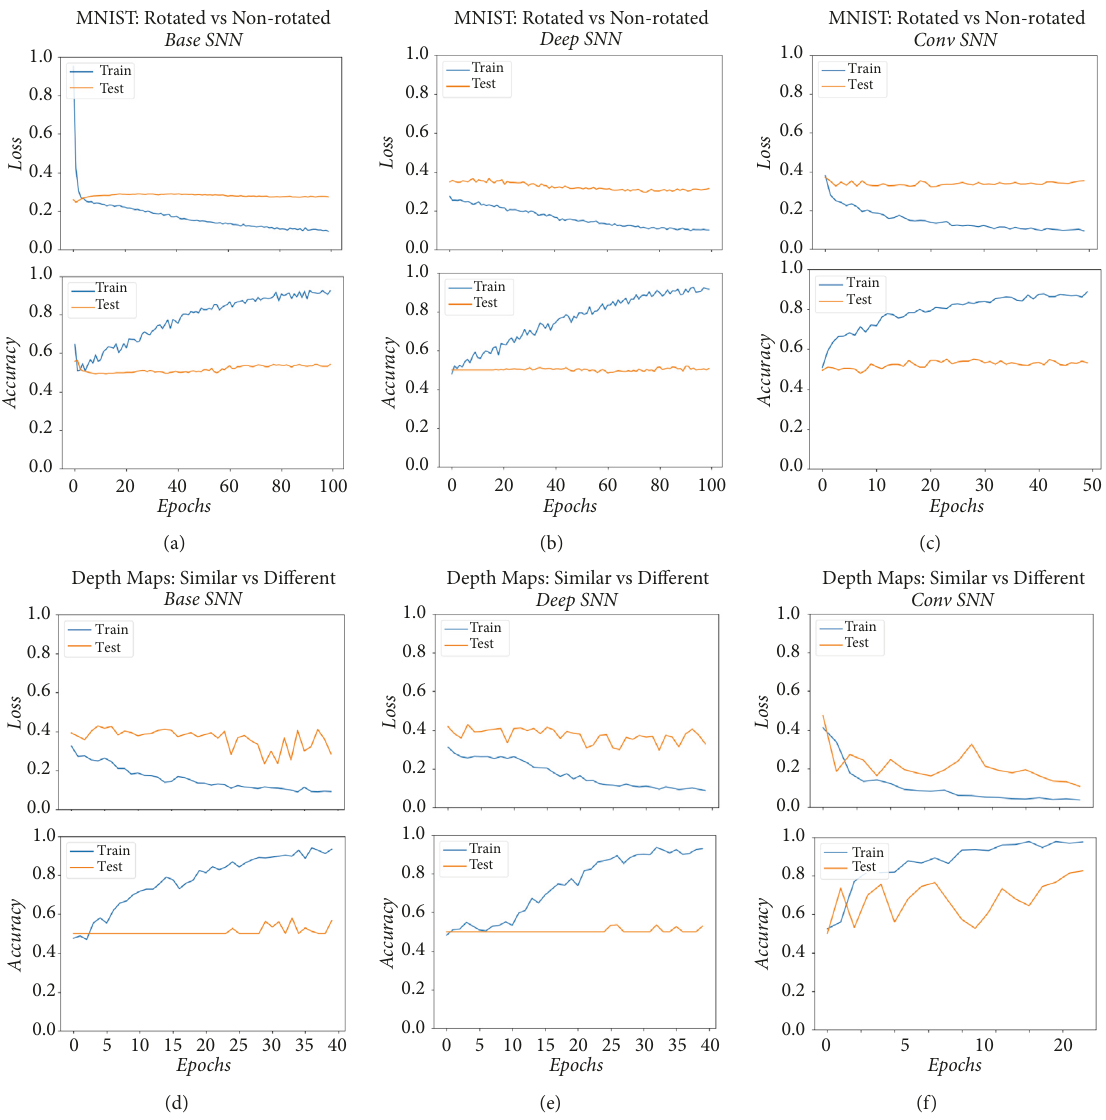
Figure 13: Plot of training loss and accuracy for (a and c) base Siamese network, (b and d) deep Siamese network, and (c and f) convolutional Siamese